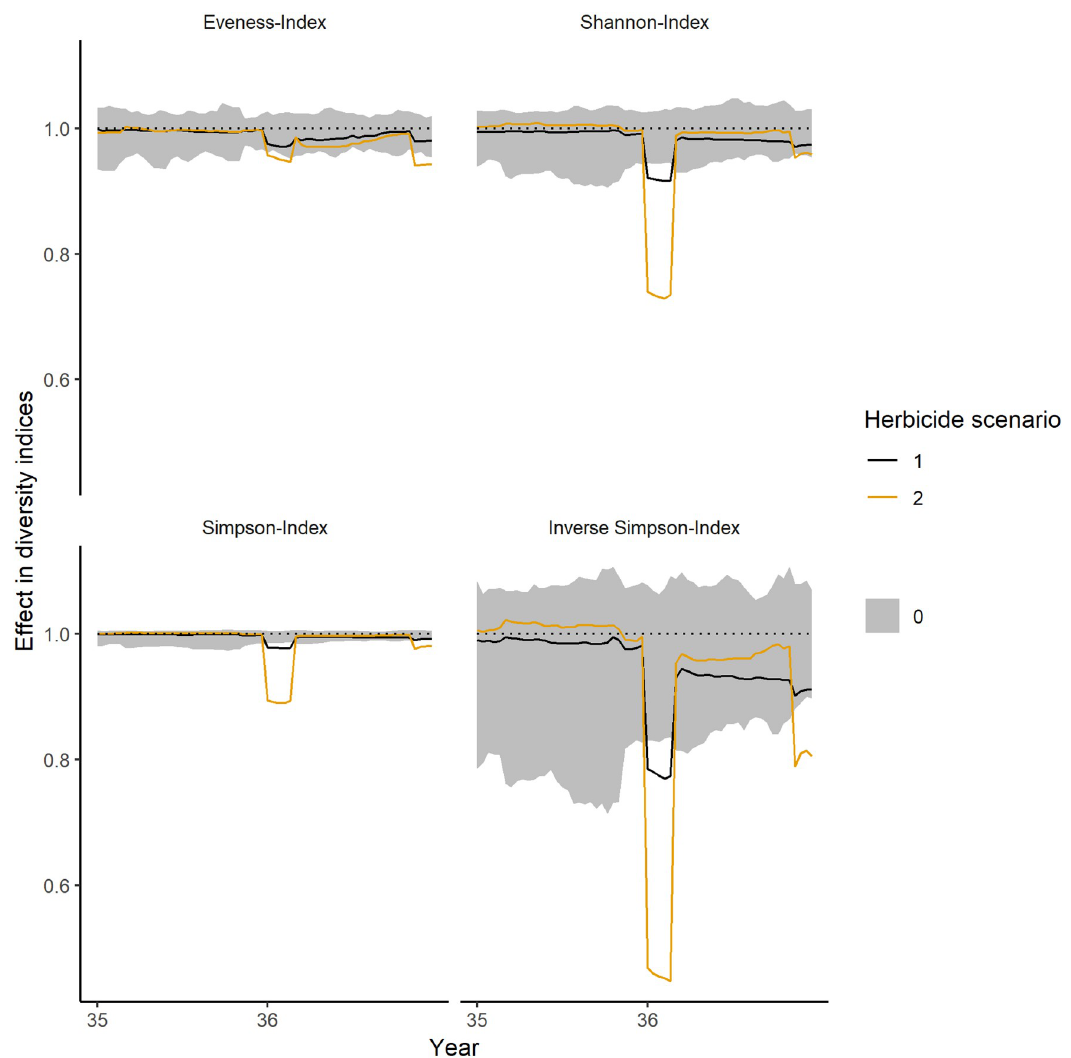
Fig 5. Short-term impacts on different diversity indices during the first year of simulated herbicide application. Values below 1 represent a negative impact, values equal to 1 no impact and values above 1 a positive impact. The theoretical herbicide had an impact on biomass and mortality. PFTs had random dose response curves. Grey ribbons show the fluctuations within control simulations, the black lines show the mean for an application rate of 1.1 g a.i./ha (herbicide scenario 1) and the orange lines the mean for an application rate of 3.3 g a.i./ha (herbicide scenario